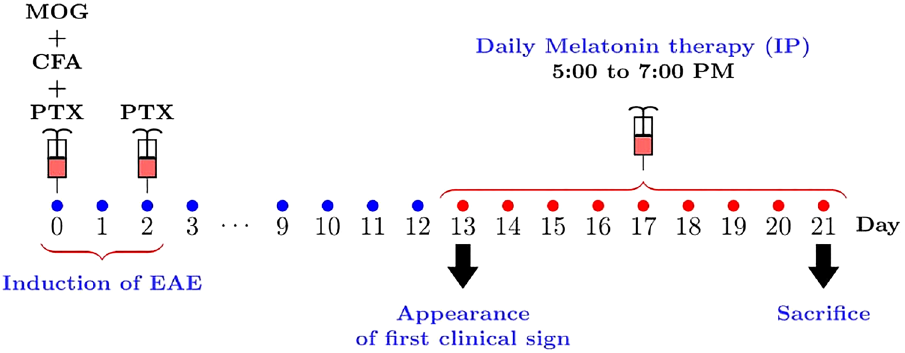
Figure 1. Schematic representation of the experimental procedures. EAE was induced in C57BL6 mice (day 0) that were treated at day 13 with various doses of melatonin until day 21. Daily clinical scores were then measured, which continued until day